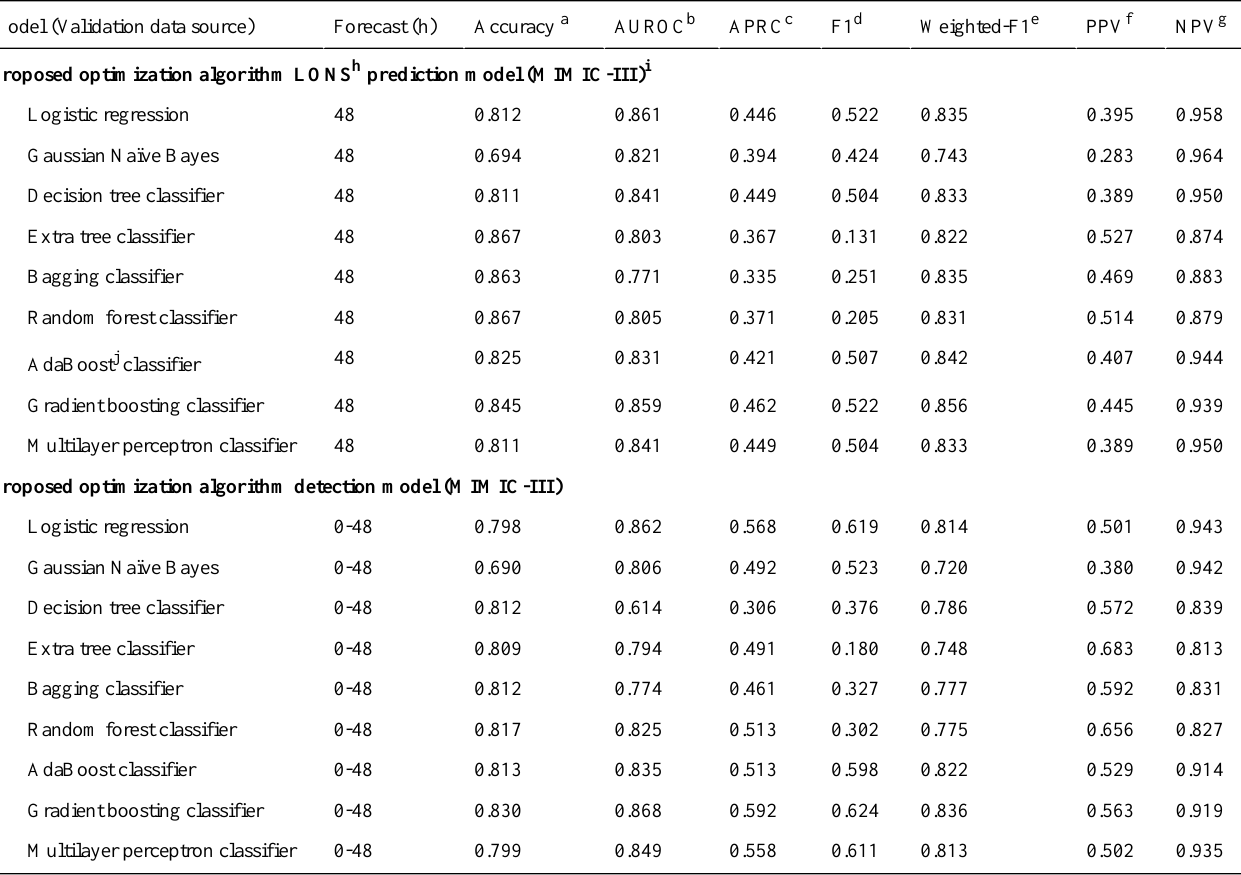
Table 6. Performance results of the prediction models (microaverage).